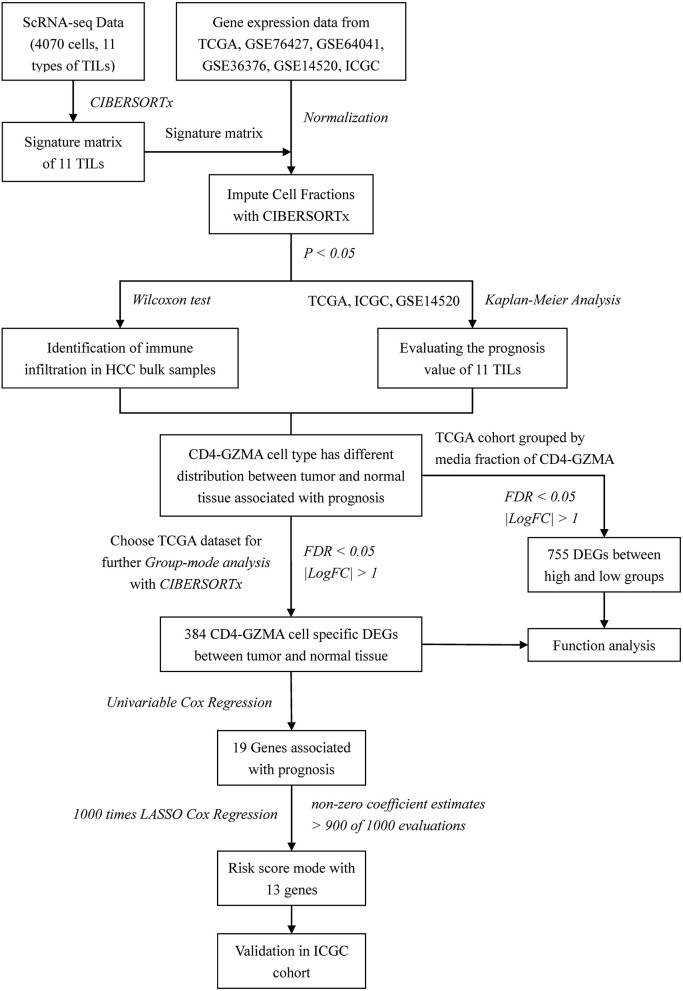
Flow chart of this study.